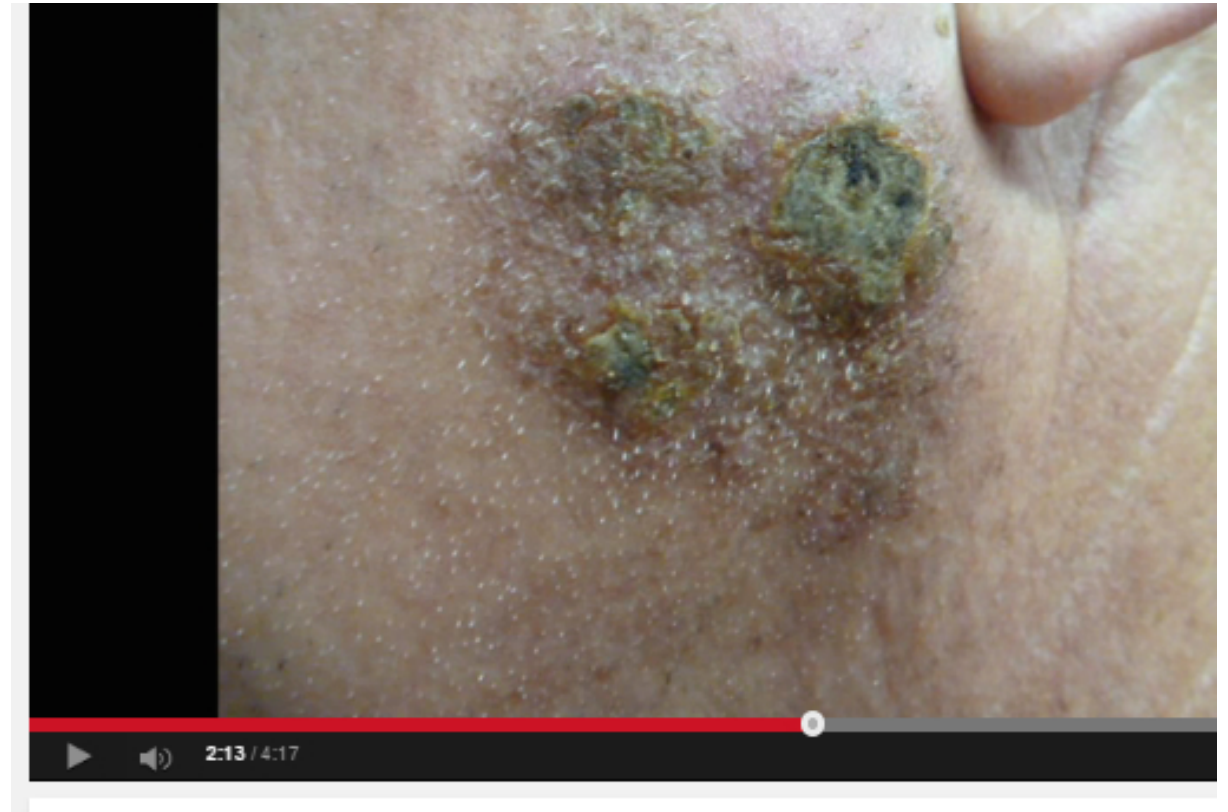
Figure 1. Screenshot for black salve success.